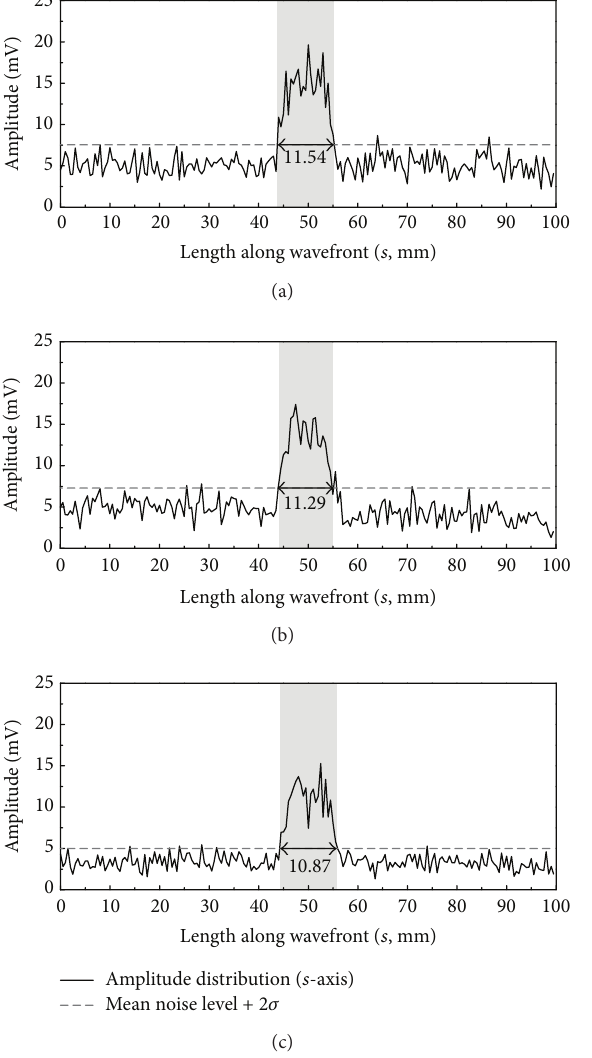
Figure 10: Crack length evaluation with the wave fields obtained in (a) the free plate (single scan), (b) the water-immersed plate (10 times scans), and (c) the glycerin-immersed plate (10 times scans).